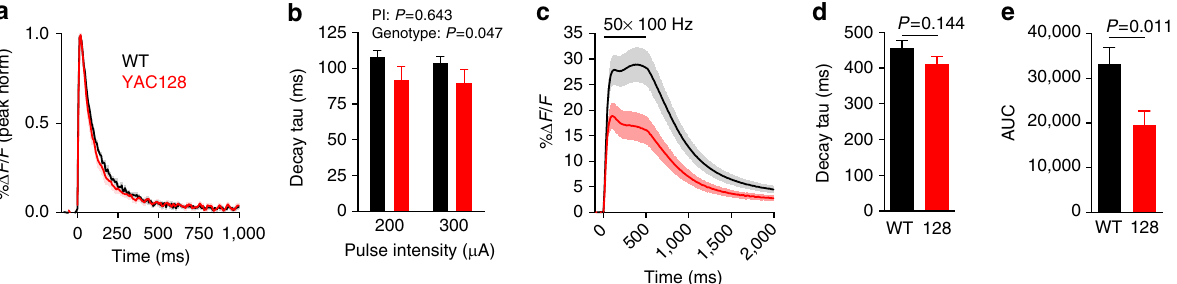
Figure 4 | Striatal neurons are exposed to lower levels of synaptically released glutamate in 15-month-old YAC128 mice. ( a ) Grouped data showing the average iGluSnFR response ( ± s.e.m.) to a single pulse (200 m A) in the dorsal striatum from WT ( FVB/N ; black) and age-matched, YAC128 (red) mice. Responses are normalized (norm) to their peaks for direct comparisons of decay time course. ( b ) Bar graph showing iGluSnFR decay in response to single pulses at different pulse intensities (PI; WT n ¼ 9 per bar; YAC128 n ¼ 8 per bar; RM two-way ANOVA). ( c ) Average iGluSnFR response to a high-frequency stimulation (HFS) consisting of 50 pulses over 500ms (200 m A). The raw data are shown to highlight the dramatic difference in the response size between WT ( n ¼ 20) and YAC128 ( n ¼ 21) under these conditions. ( d ) Bar graph showing the decay tau from the experiments in c (unpaired t -test). ( e ) Bar graph showing the area under the curve (AUC) from the experiments shown in c (unpaired t